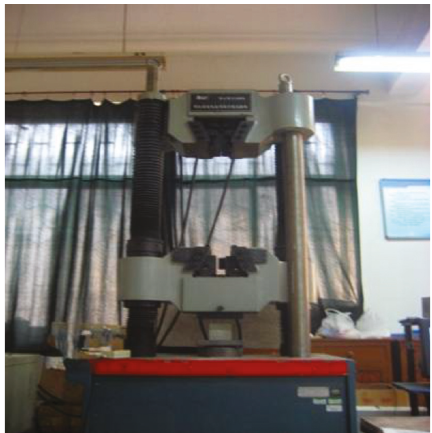
Figure 4: WAW3100 electrohydraulic servo testing